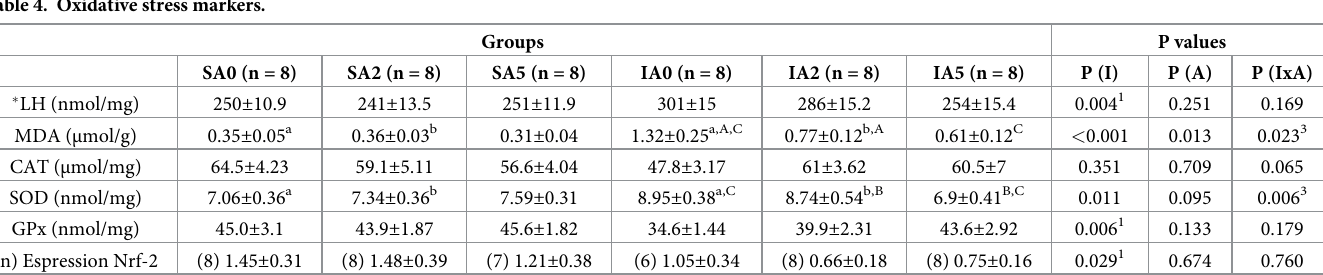
Table 4. Oxidative stress markers.